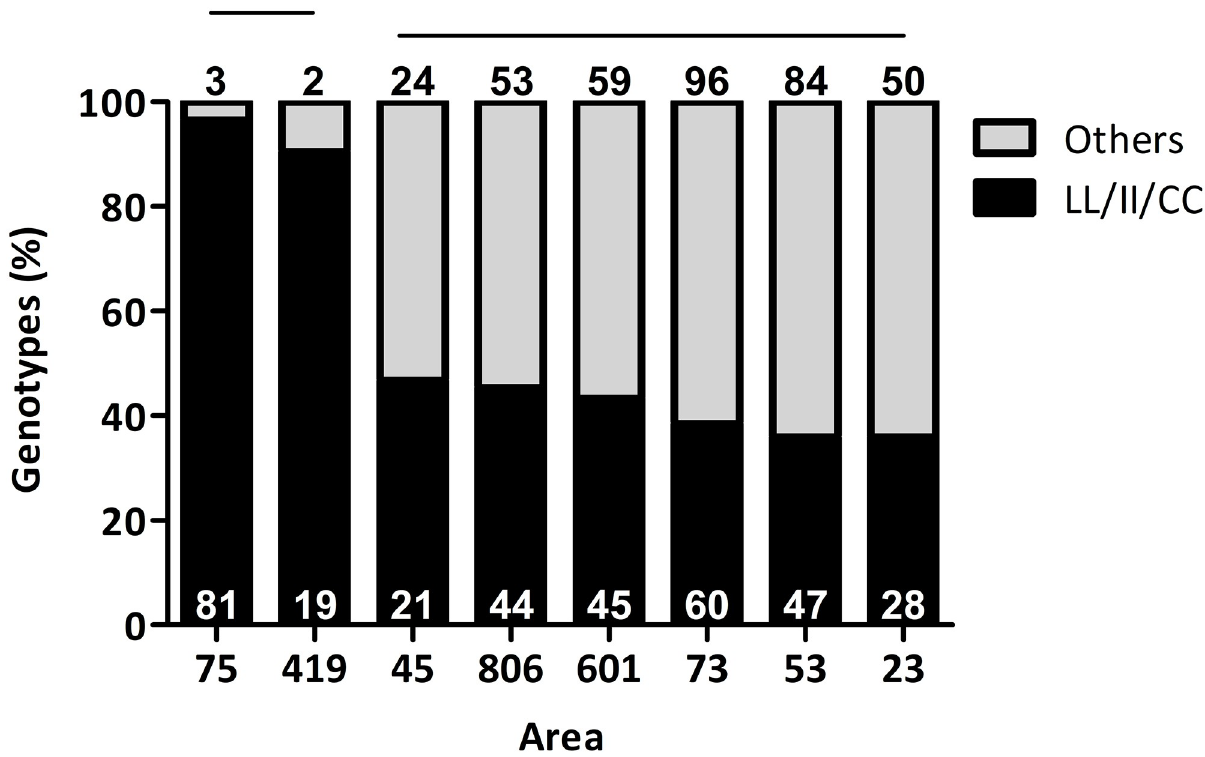
Fig 2. Percentage of tri-locus homozygous resistant genotypes at the 410, 1016 and 1534 sites (LL/II/CC) vs other tri-locus genotypes detected per area. Percentage of the tri-locus (LL/II/CC) kdr mutation in females of Ae . aegypti . Significant differences were detected among the proportion of LL/II/ CC genotypes observed across all areas (Chi-square; P < 0.0001). Horizontal lines above bars indicate areas in which the percentage of genotypes are not significantly different as per pairwise comparison analyses (Fisher Exact test; P < 0.05). White numbers in the black bars represent the number of females of the LL/II/CC genotype and black numbers above the bars represent all other genotypes observed in each area.